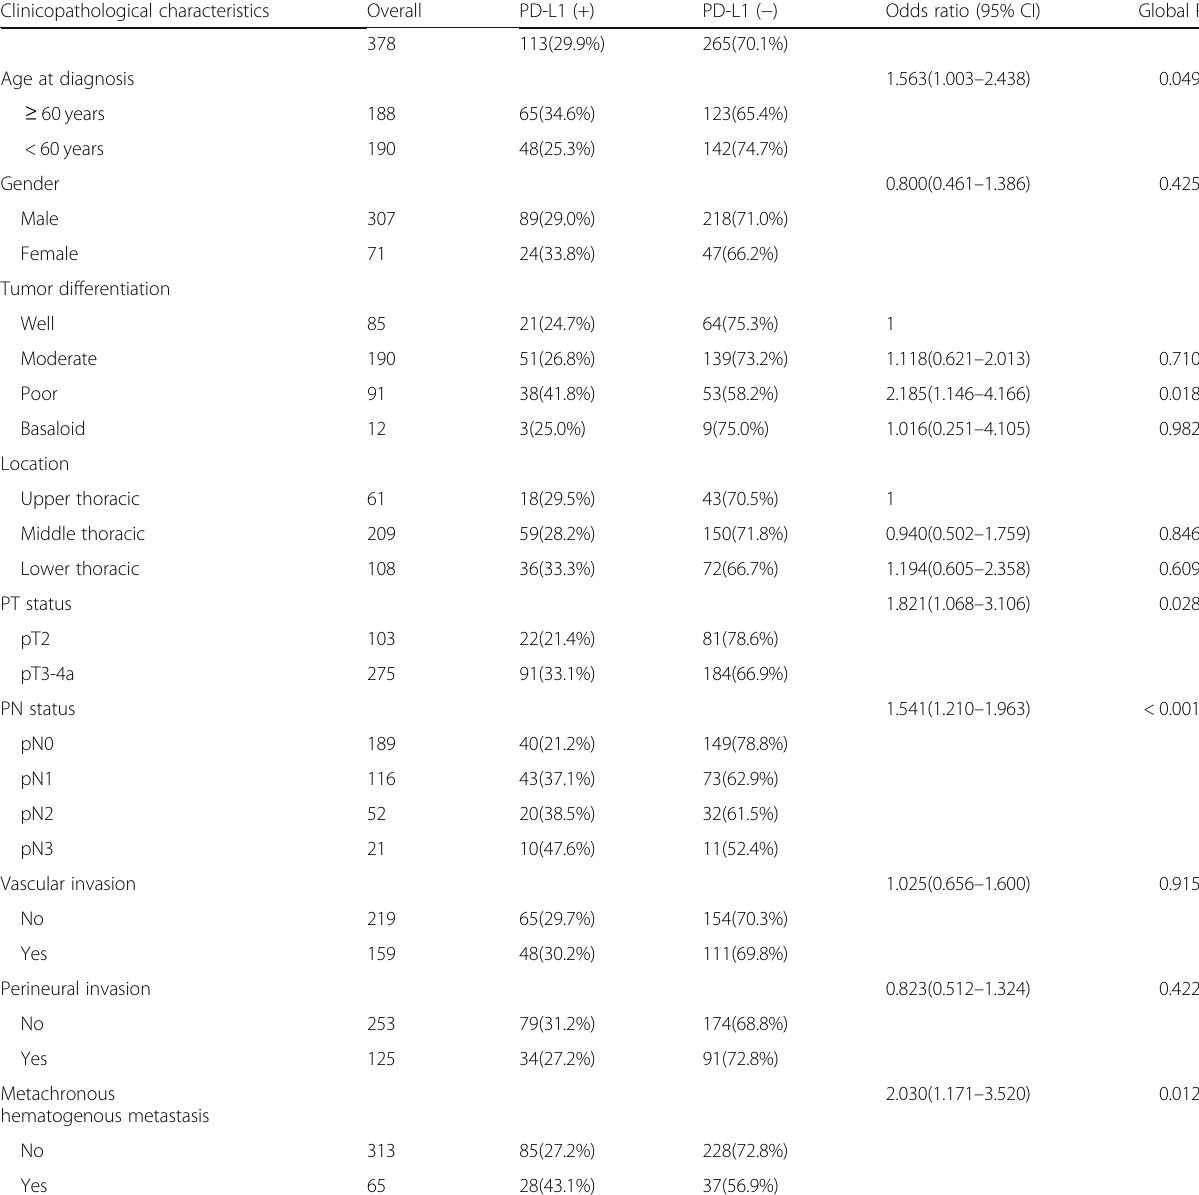
Table 2 Relationships between clinicopathological characteristics and PD-L1 expression in tumor cells Clinicopathological